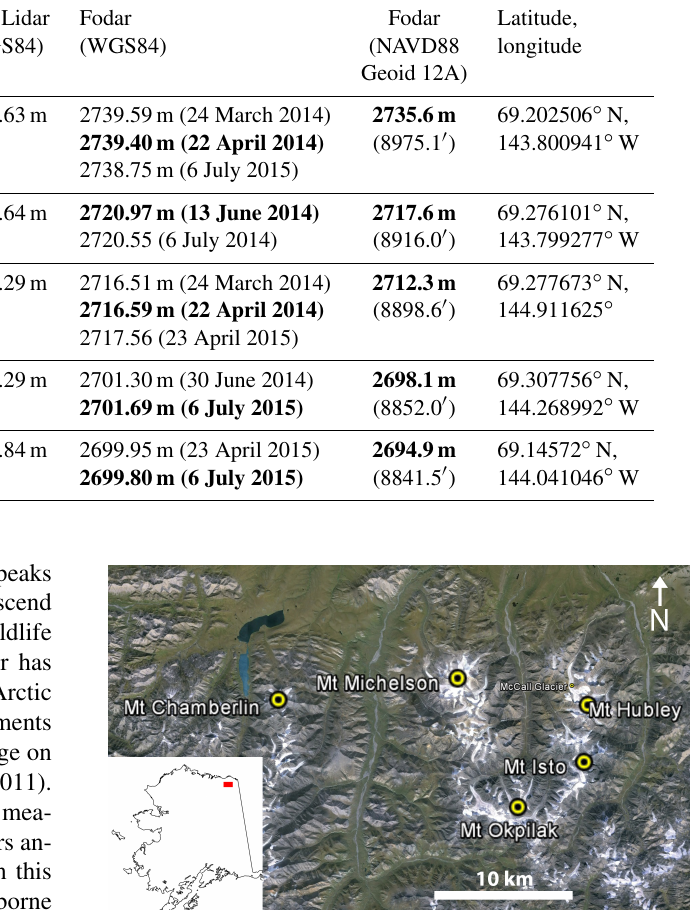
Table 1. Elevations of the five tallest peaks in the US Arctic. USGS peak elevations in feet are taken directly from labels on the printed map sheets except for Mt. Okpilak at 1:63360, which was interpolated from the contours surrounding the peak; Mt. Okpilak is our unofficial name for that unnamed peak. Fodar data were processed in WGS84 for comparison with ground control; as described in the text, we selected one of these measurements (bold) for the final value, which was converted to NAD83 using GEOID12A and presented in column 6, with its geographic coordinate shown in column 7.